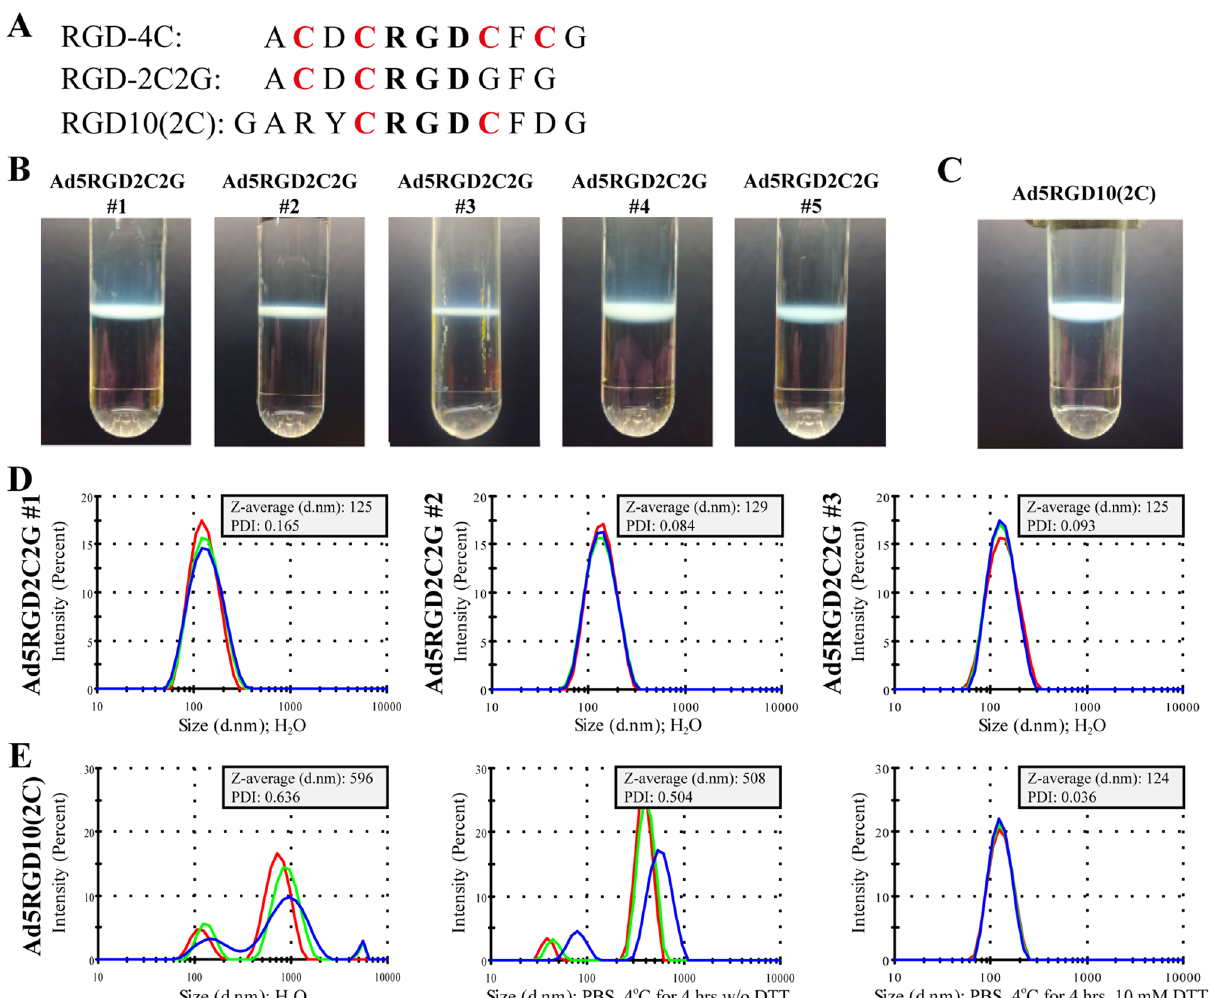
Figure 3. A cysteine-to-glycine substitution at positions after the RGD motif within the RGD-4C peptide in the HI loop of the fiber knob domain prevented viral aggregation during 2 × CsCl gradient ultracentrifugation. ( A ) The amino acid sequences of the RGD-4C, RGD-2C2G, and RGD10(2C) peptides containing 4, 2, and 2 cysteine residues, respectively, which were inserted in the HI loop of the fiber knob protein after a Thr residue at position 546. ( B ) No macroscopic aggregation of Ad5-delta-24-RGD2C2G with the RGD-2C2G peptide in the HI loop of the fiber knob domain during 2 × CsCl gradient ultracentrifugation (five independent viral preparations). ( C ) No macroscopic aggregation of Ad5-delta-24-RGD10(2C) with the RGD10(2C) peptide in the HI loop of the fiber knob domain during 2 × CsCl gradient ultracentrifugation. ( D ) The absence of aggregation (PDI ≤ 0.2) of Ad5-delta-24-RGD2C2G confirmed by photon correlation spectroscopy. Representative measurements are shown. ( E ) Microscopic aggregation (PDI ≈ 0.6) of Ad5-delta-24-RGD10(2C) could be resolved by incubating with DTT. The measurements of the intensity weighted mean hydrodynamic sizes (Z-averages, d.nm) and polydispersity indices (PDI) were carried out at a rAd concentration of 3 × 10